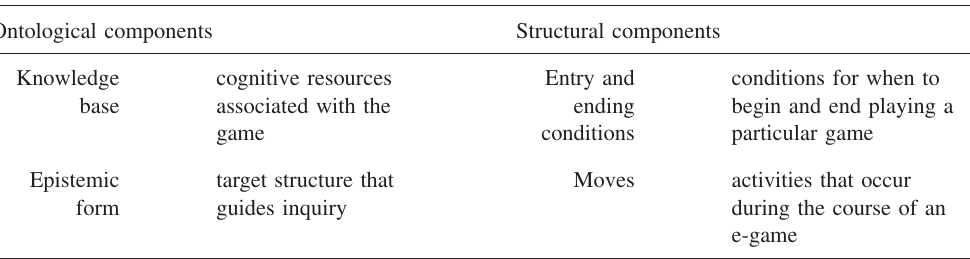
TABLE I. The ontological and structural components of epistemic games.